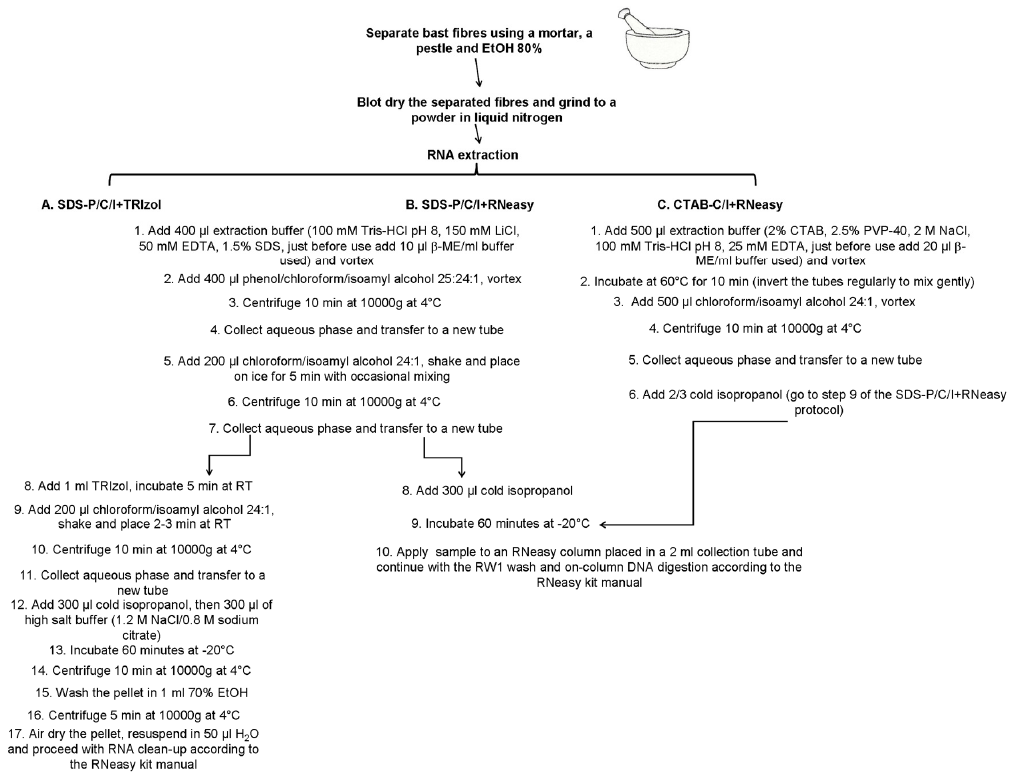
Figure 1. Scheme showing three RNA extraction protocols used in the study. Details on the buffer composition are also provided.